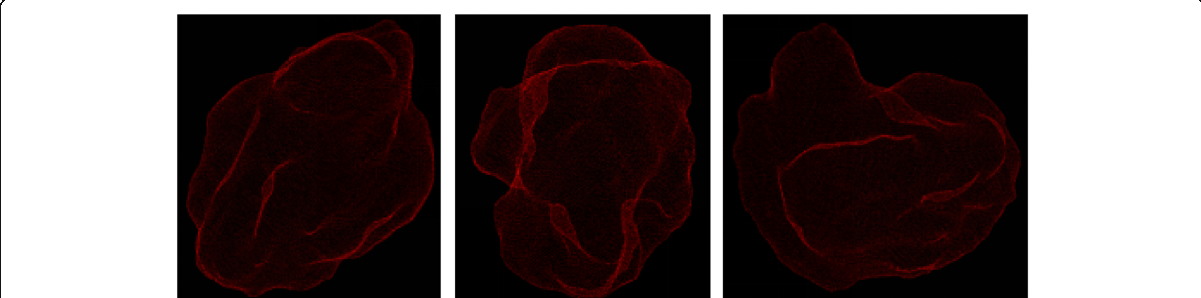
Fig. 6 The point cloud